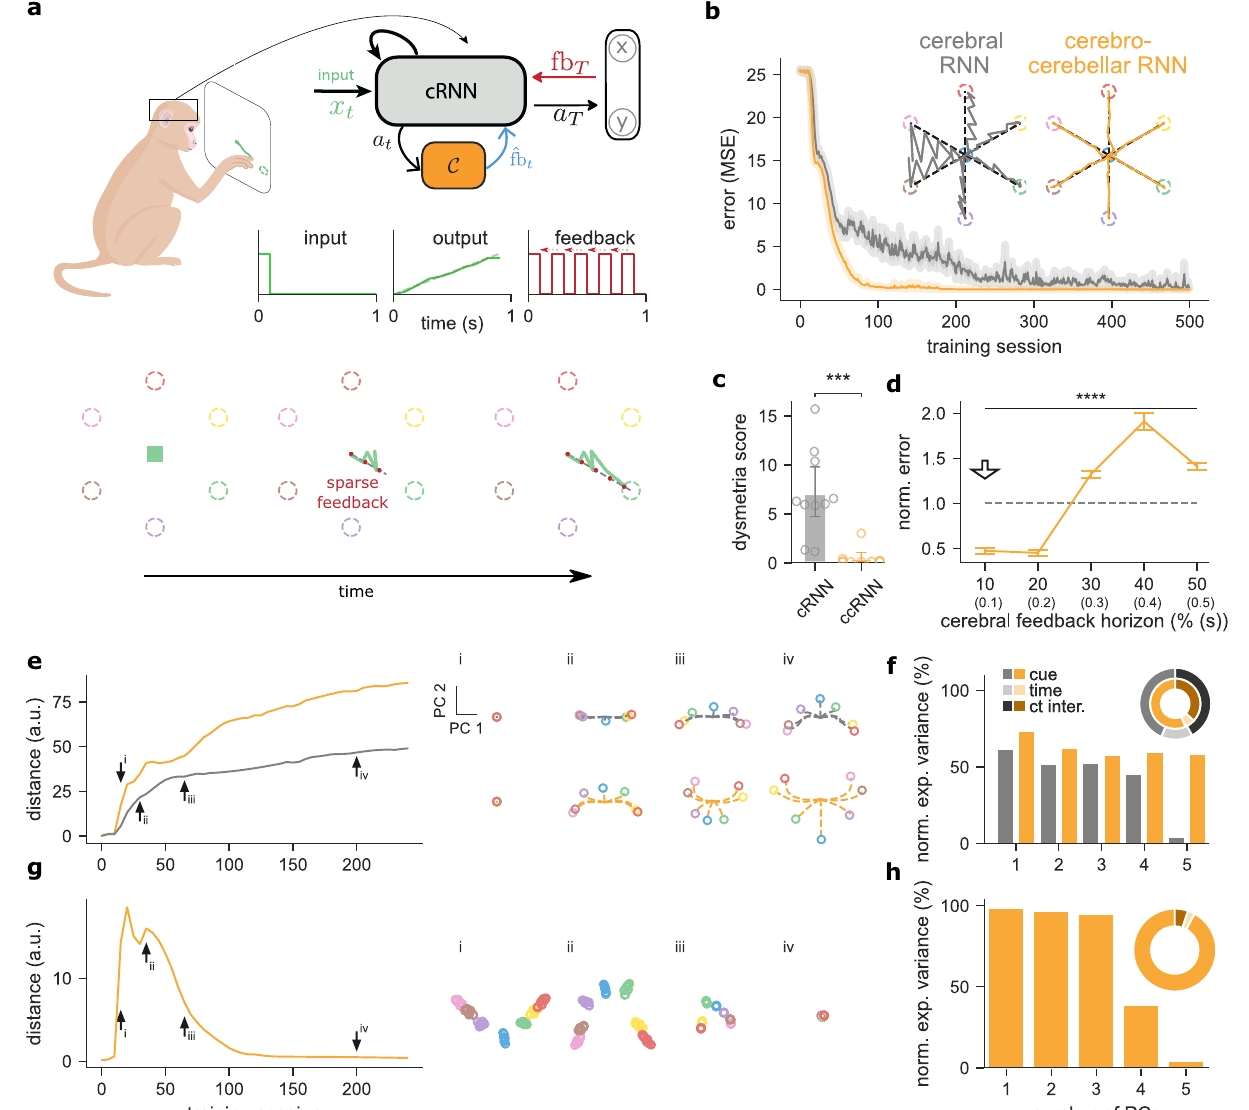
Fig. 2 | Cerebro-cerebellar model improves learning in a simple line drawing sensorimotor task. a Schematic of a macaque monkey performing a simple line drawing task (top left). A cerebro-cerebellar RNN (ccRNN) in the macaque ’ s brain receives cue-speci fi cinput and learnsto producethedesired trajectory(top right). The temporal pro fi le of input, output (dashed gray line represents the target tra- jectory) and feedback are also shown (bottom right). There are six possible tar- get lines (coloured dashed circles; plus a 7th target for which the model must remain still) and feedback (dashed gray line) is provided at a regular interval (bottom;seethe “ Methods ” section).Intheexampleshownthemodelmustdrawa straight line toward the green target. b Error between model output and desired target trajectories for cerebellar RNN (gray, cRNN) and cerebro-cerebellar RNN (orange, ccRNN). Insets: Model trajectory produced for all cues after learning. c Dysmetria score for cRNN and ccRNN. The dysmetria score quanti fi es how smooth the movement is after learning (see the “ Methods ” section). d Normalized model mean squared error after learning for different cerebral feedback horizons. Feedback horizon is denoted as a percentage of the total task sequence. Arrow indicates the feedback horizon used by the cerebral network in the other panels. e EuclideandistancebetweenthecerebralRNNdynamicscorrespondingtothetwo leading cue-speci fi c principal components. Results are given for both the cRNN